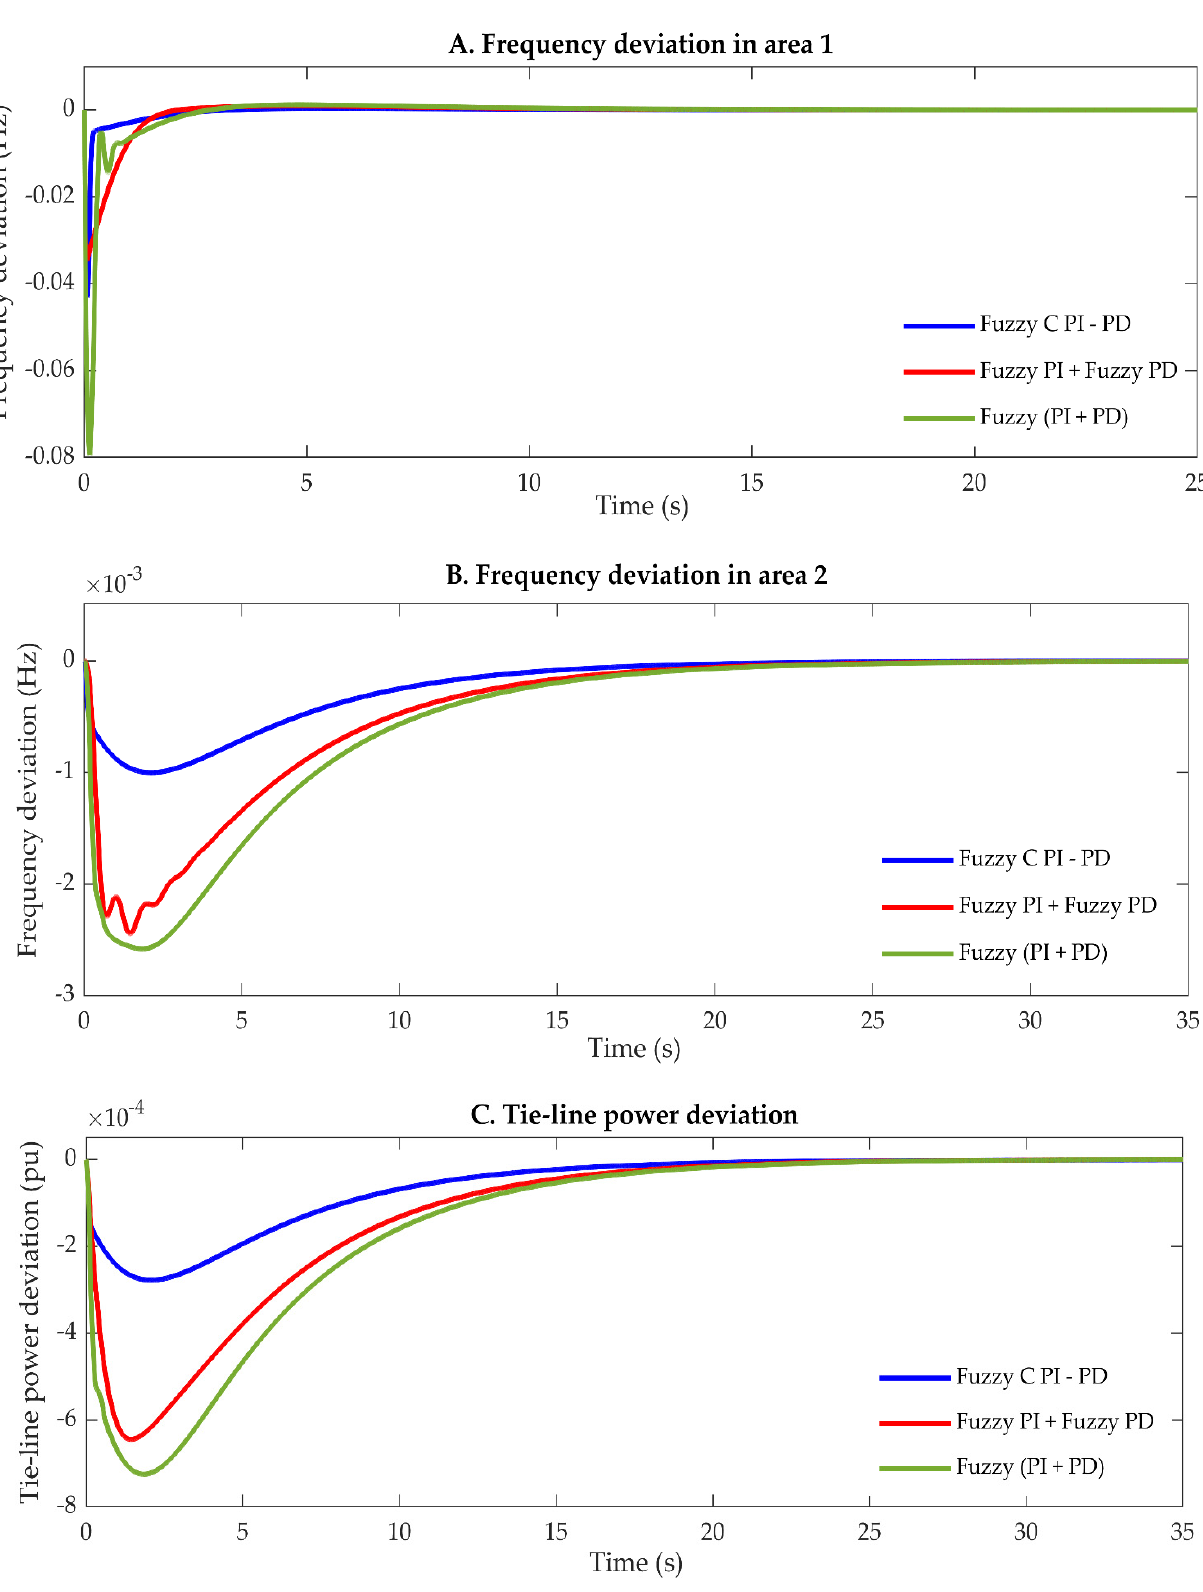
Figure 29. Dynamic response of the testbed power system based on different fuzzy controllers under parametric uncertainty conditions, case 8. ( A ) Frequency variation in area 1; ( B ) frequency variation in area 2; ( C ) tie-line power variation.